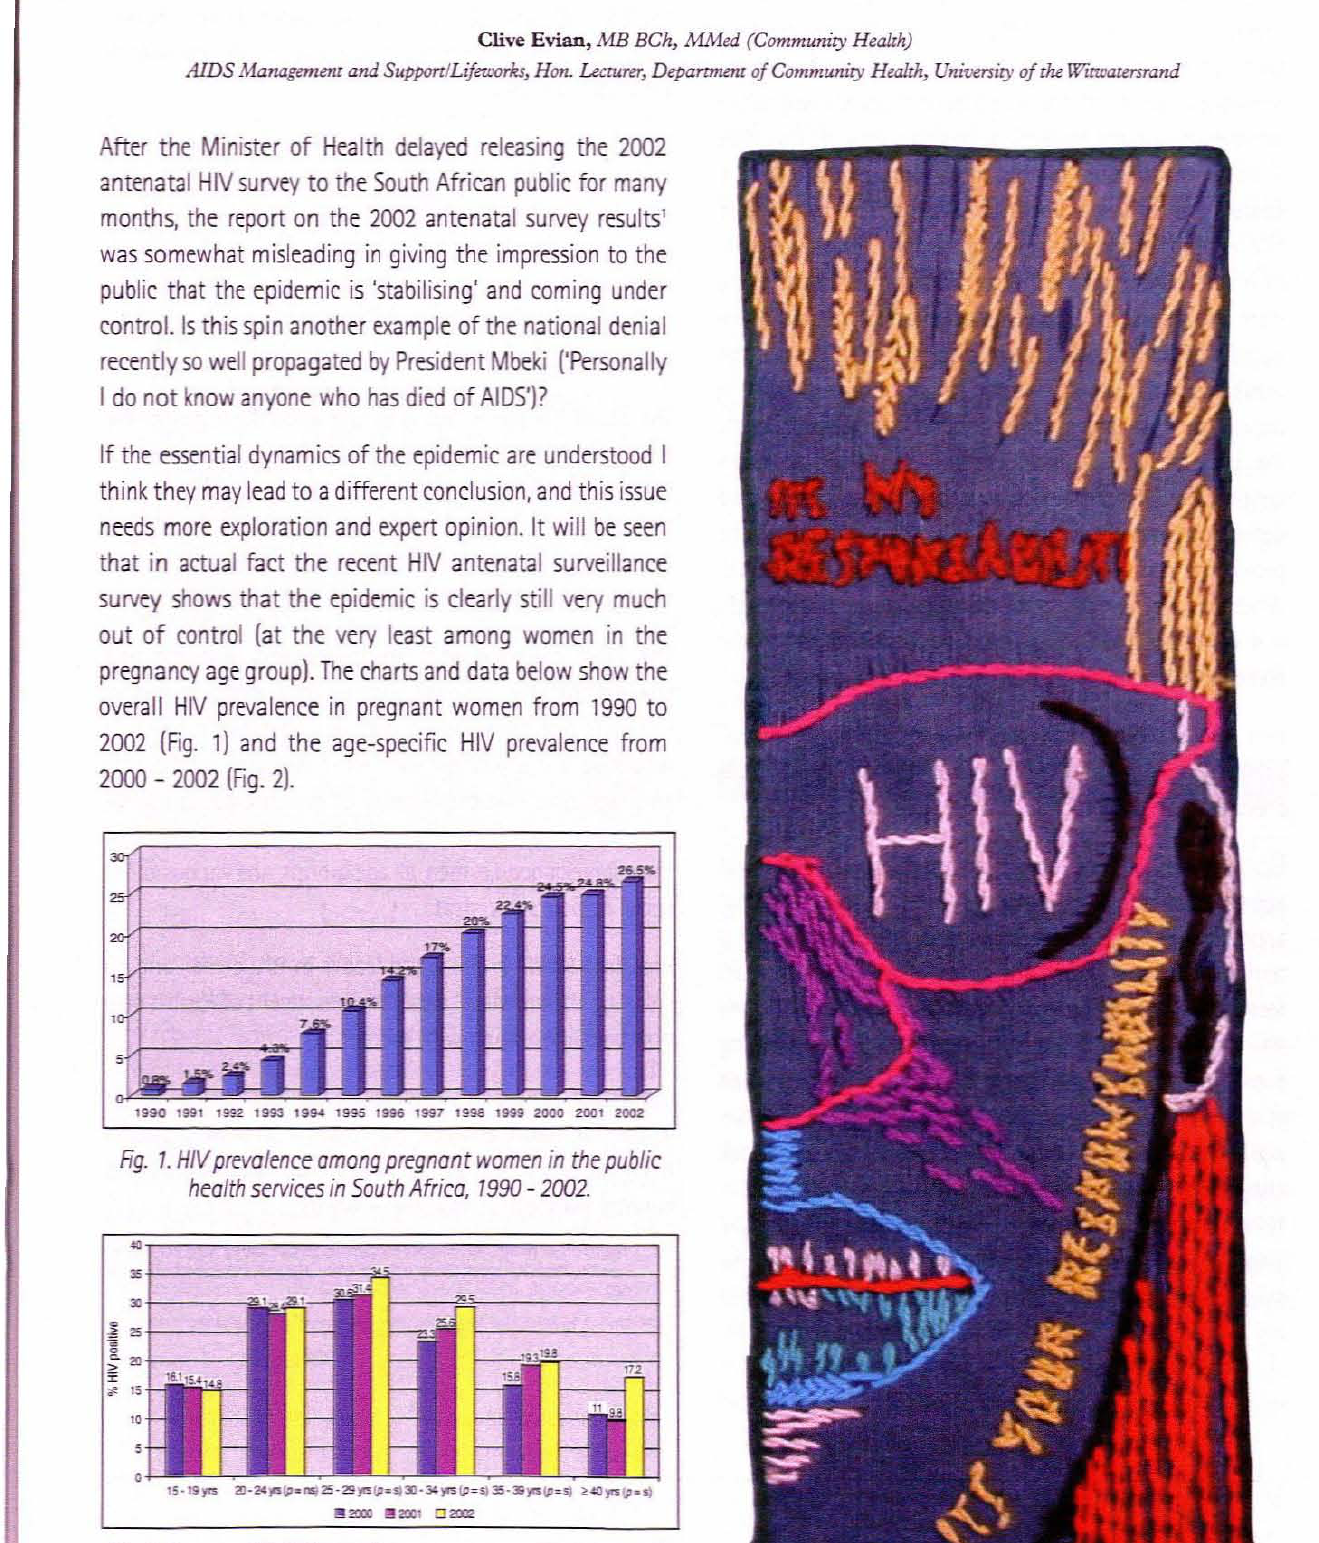
Fig. 1. HIVprevalence among pregnant women in the public health services in South Africa, 1990 -